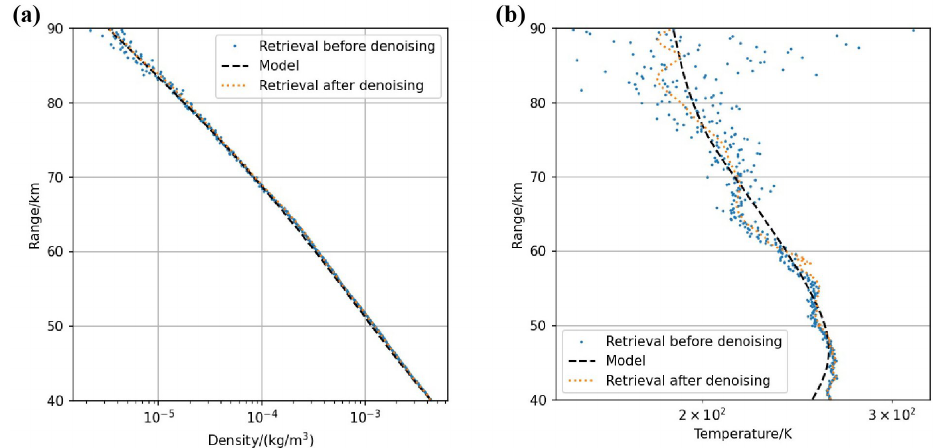
Figure 11. The variation of ( a ) density and ( b ) temperature retrievals with WT-EEMD-LOWESS algorithm of ground-based